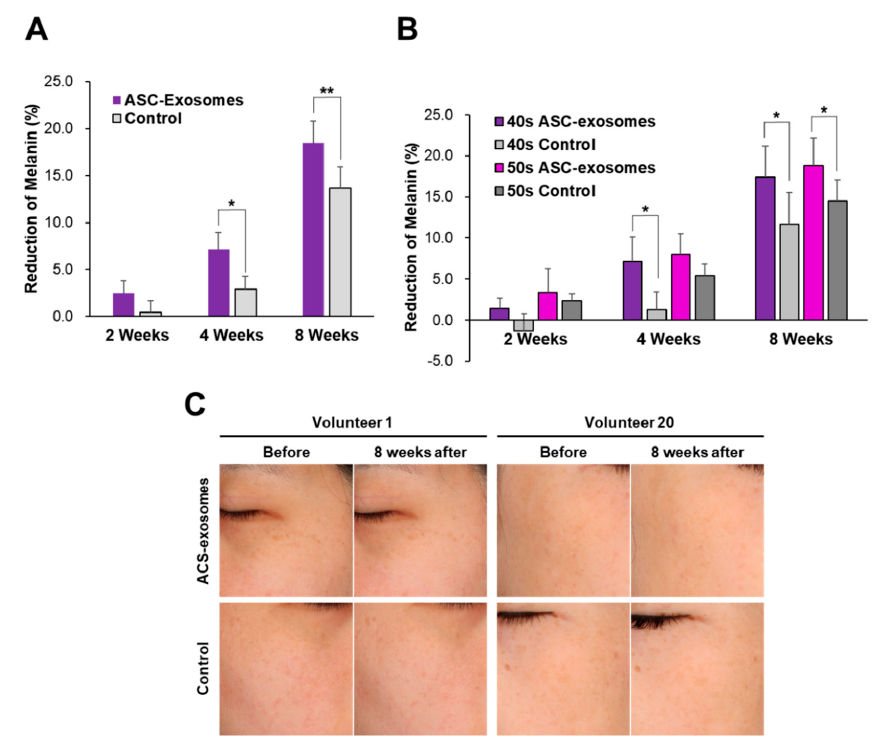
Figure 4. Clinical evaluation of the skin brightening effect of ASC-exosomes. Melanin levels were measured using a Mexameter on the faces of 21 female volunteers before and 2, 4, and 8 weeks after treatment with a placebo (without ASC-exosomes) or test (with ASC-exosome) formulation twice daily for 8 weeks. ( A ) Reduction of melanin over time. ( B ) Reduction of melanin in different age groups. n = 11 for 40s and n = 8 for 50s. * p < 0.05 and ** p < 0.01 vs. placebo-treated area was considered statistically significant. ( C ) Representative images of two volunteers.